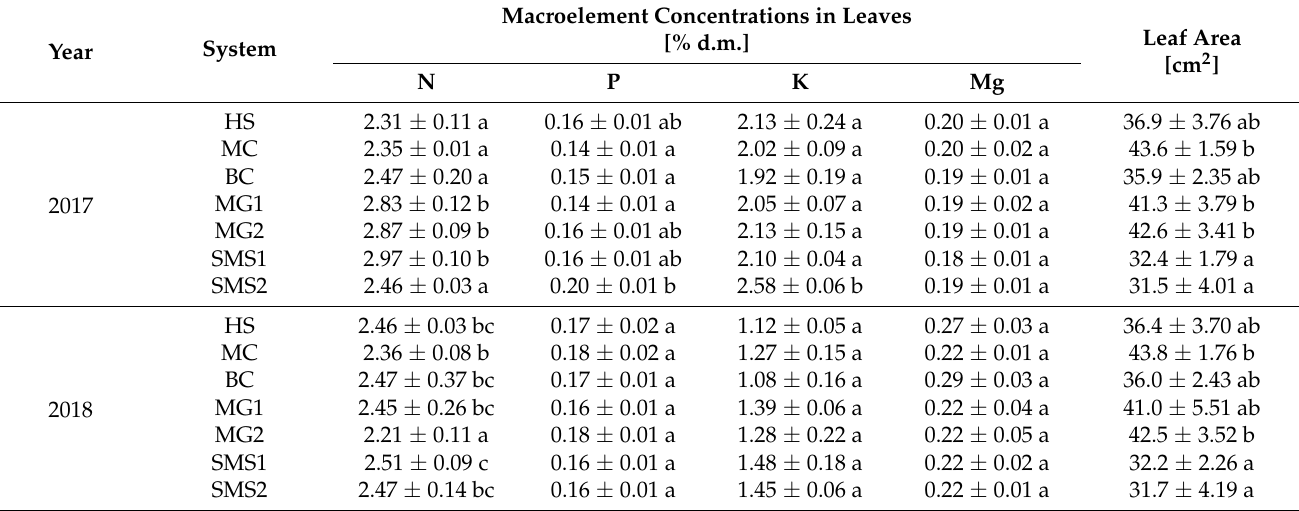
Table 4. Macro-nutrient contents in the leaves and leaf areas of tested apple trees with different floor management systems in